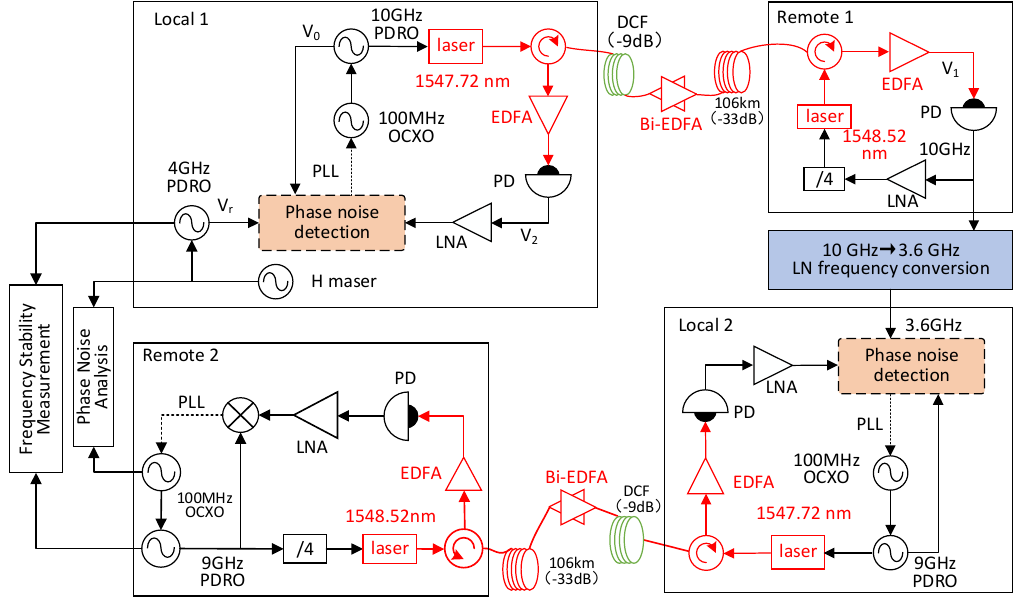
Figure 3. Scheme of the cascaded microwave frequency dissemination system; LNA: low-noise amplifier; Bi-EDFA: bidirectional Er-doped fiber optical amplifier; EDFA: unidirectional Er-doped fiber optical amplifier; DCF: dispersion compensation fiber; PD: photodetector; PDRO: phase-lock dielectric resonance oscillator; OCXO: oven-controlled crystal oscillator; MZM: Mach–Zehnder modulator; PD: photodetector.